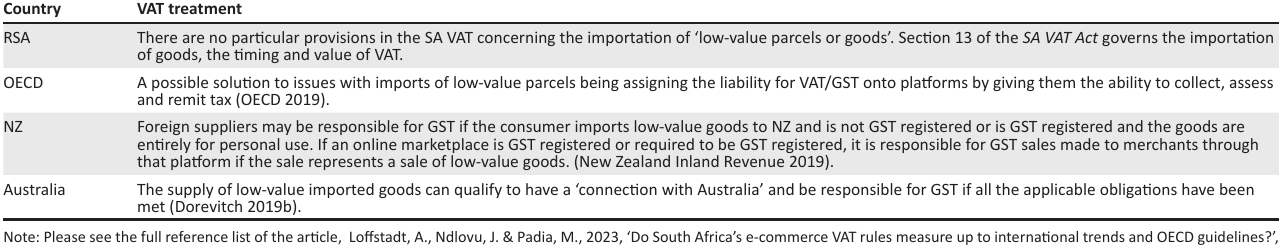
TABLE 7: A comparison of the value-added tax treatment of imports of low-value parcels in Republic of South Africa, Organisation for Economic Co-operation and Development guidelines, New Zealand and Australia. Country VAT treatment RSA